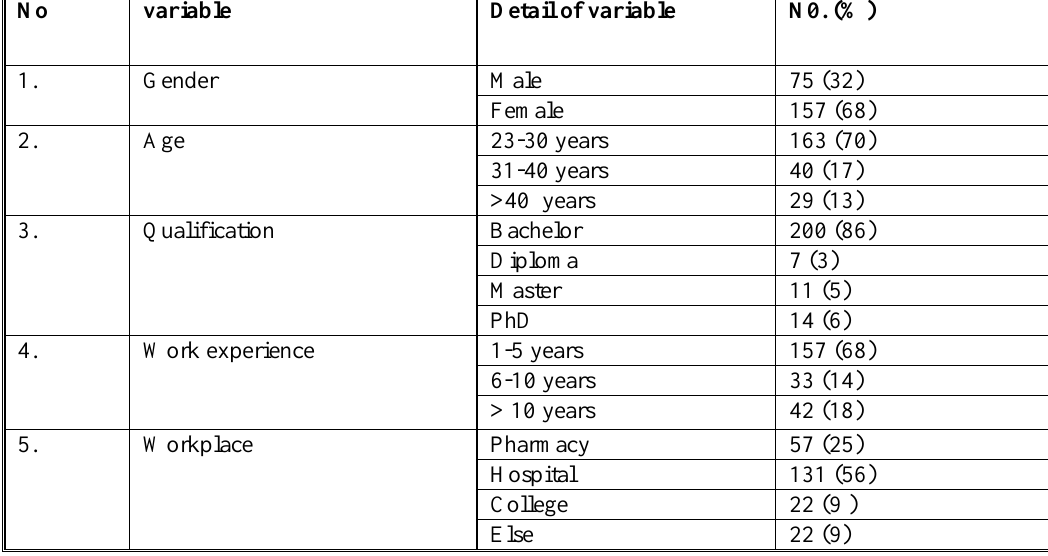
Table 1. The demographic data for participants. (N= 232)